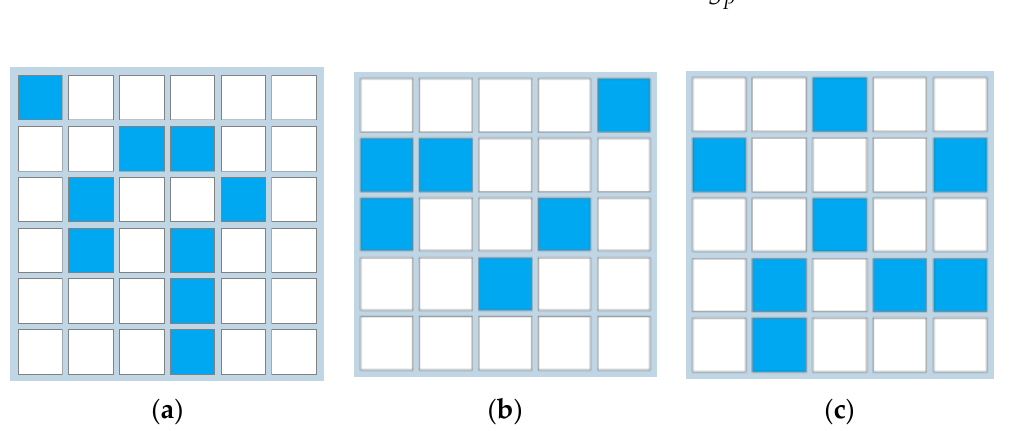
Figure 5. Example of the grid configuration with the numerical values corresponding to the cells.